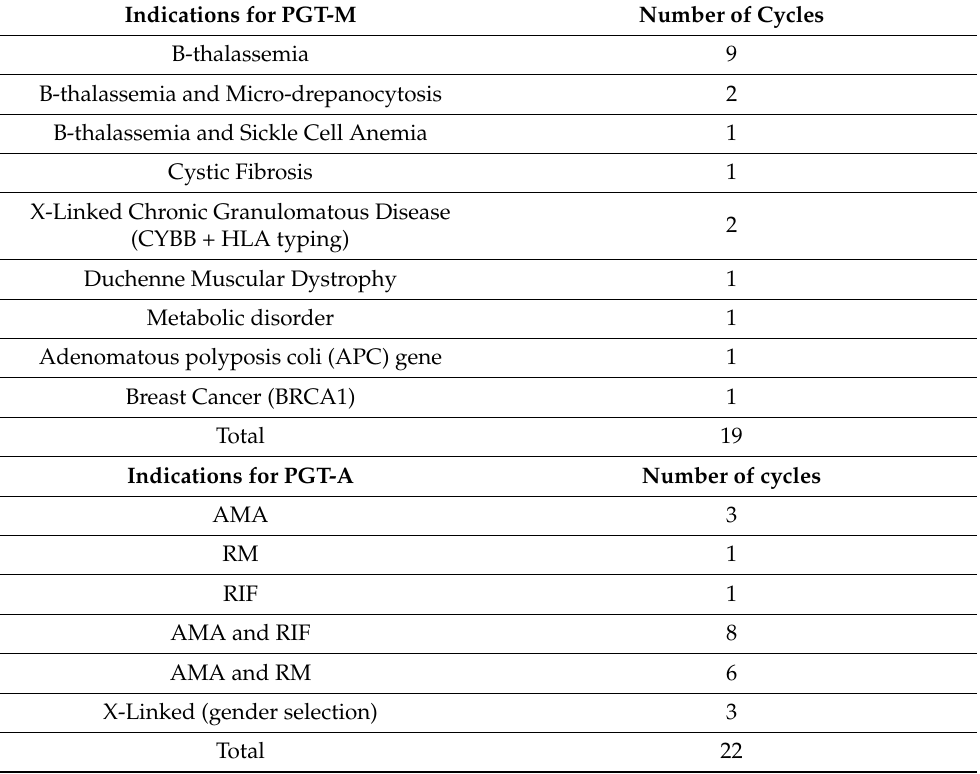
Table 3. Indications for PGT-M and PGT-A.